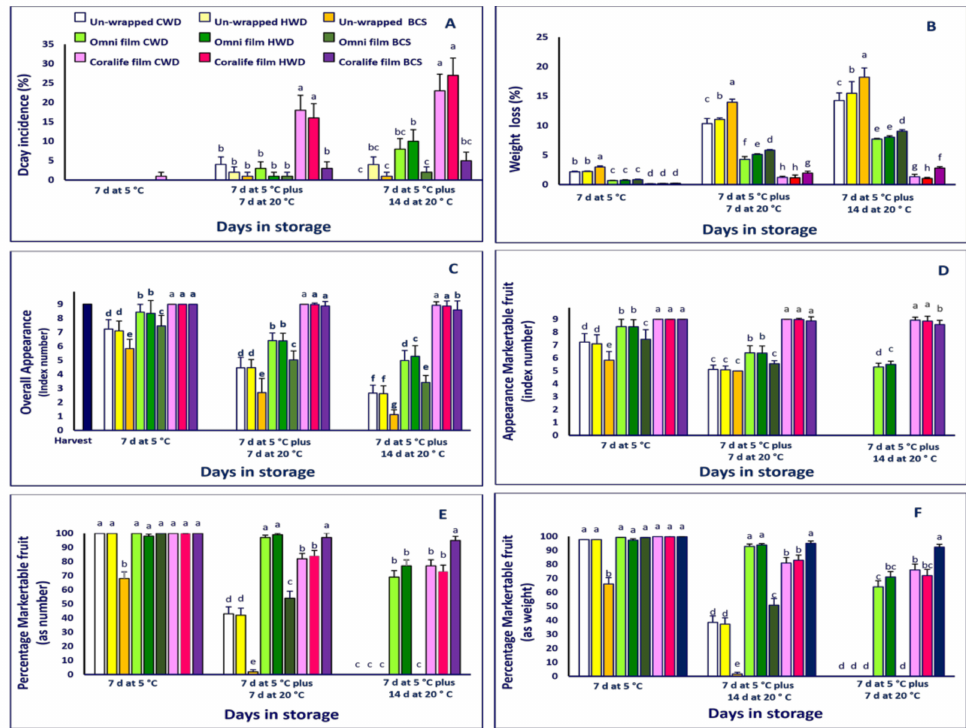
Figure 3. Decay incidence ( A ), weight loss ( B ), overall appearance ( C ), appearance of marketable fruit ( D ), percentage of marketable fruit as number ( E ), and weight ( F ) compared to harvest time of ‘Simeto’ mandarins. For each storage period, means followed by unlike letters are significantly different at p ≤ 0.05. Means separation was accomplished using Duncan’s multiple range test. Vertical bars are the standard deviations of ten replications (n = 10), each composed of 10 fruits minus the number rotten